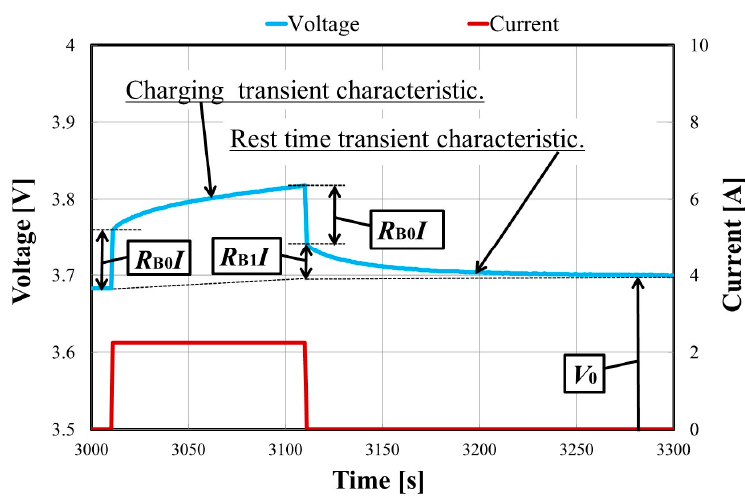
Figure 1. Transient voltage response against pulse current charging.